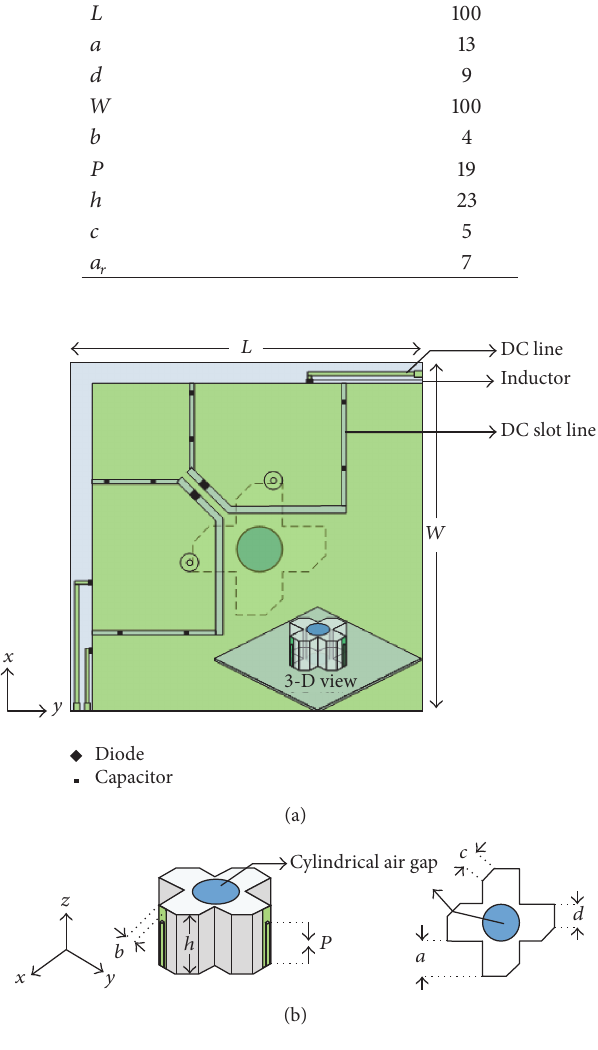
Figure 1: Schematic of the proposed antenna showing bottom, 3D, and top views. The bottom view depicts slots, DC bias lines, diodes, capacitors, and